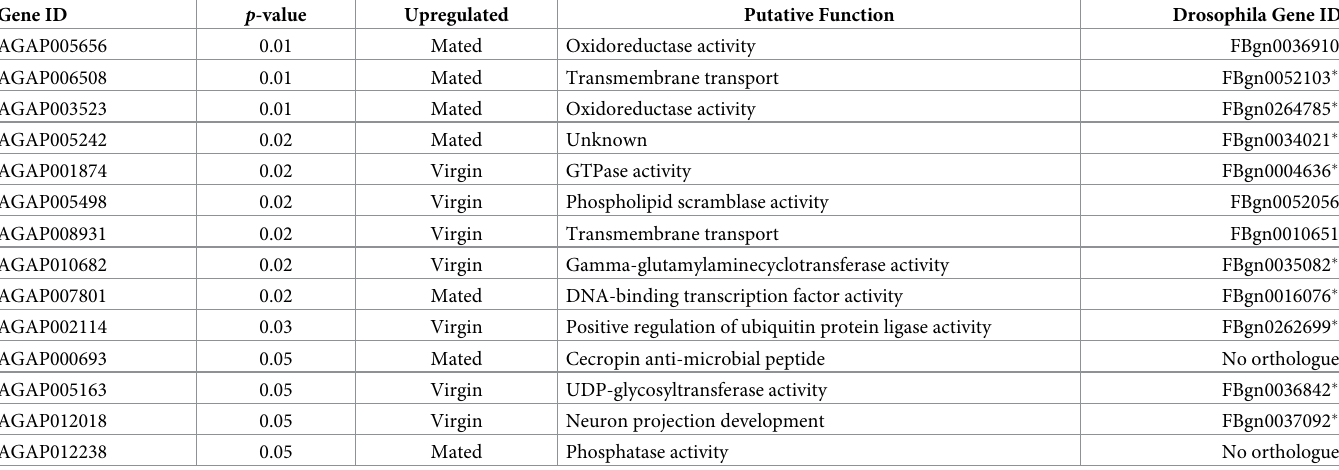
Table 1. List of genes differentially expressed in response to mating independent of feeding status. ( � ) represents 1-to-1 orthologue. Gene ID p -value Upregulated Putative Function Drosophila Gene ID